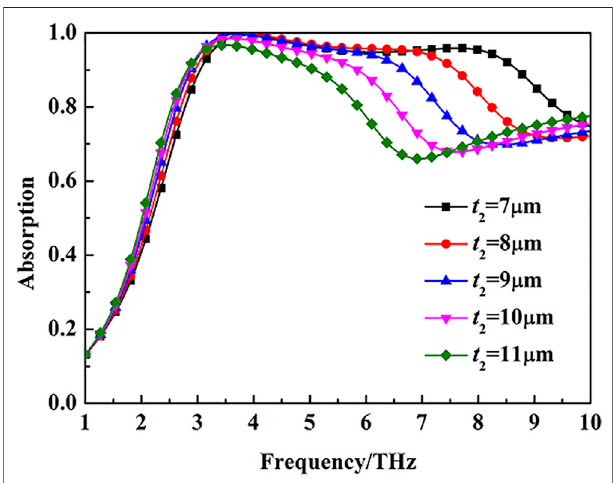
FIGURE 9 | The absorption of the metamaterial absorber with different thickness of polyimide dielectric substrates ( T (cid:1) 300 K).